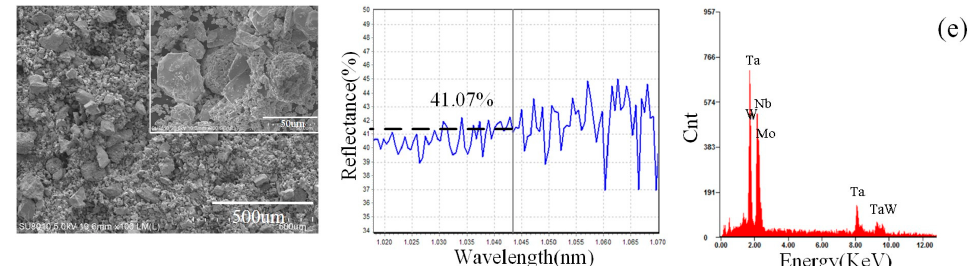
Figure 2. Basic physical properties of powders (left: shapes of powders; middle: laser absorption of powders; right: energy spectrums). ( a ) Nb, ( b ) Mo, ( c ) Ta, ( d ) W, and ( e ) mixed powders.